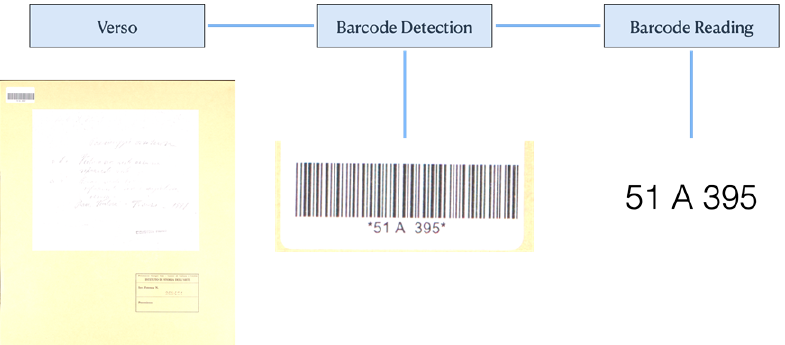
Figure 7. Schema of Cardboard Verso - Barcode Detection .